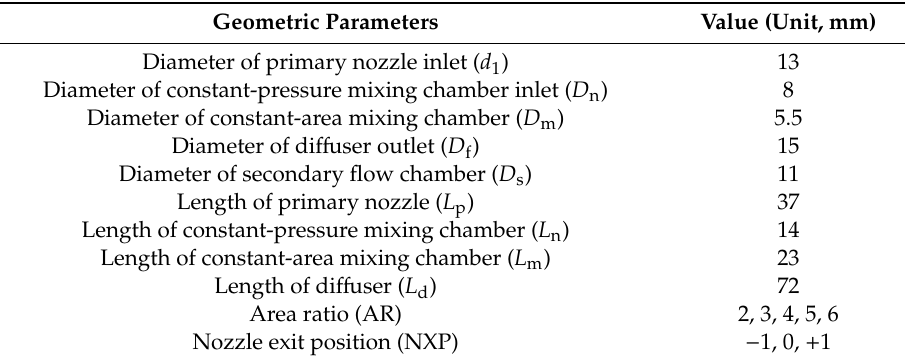
Table 1. Main geometric parameters of the